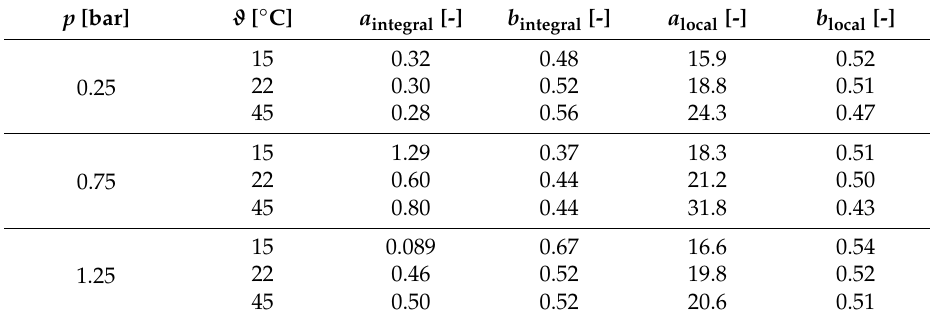
Table 3. Fit parameters a and b of modelling the permeate mass and deposit height by m ( t ), h d ( t ) = a ∗ t b . p [bar] ϑ [ ◦ C] a integral [-] b integral [-] a local [-] b local